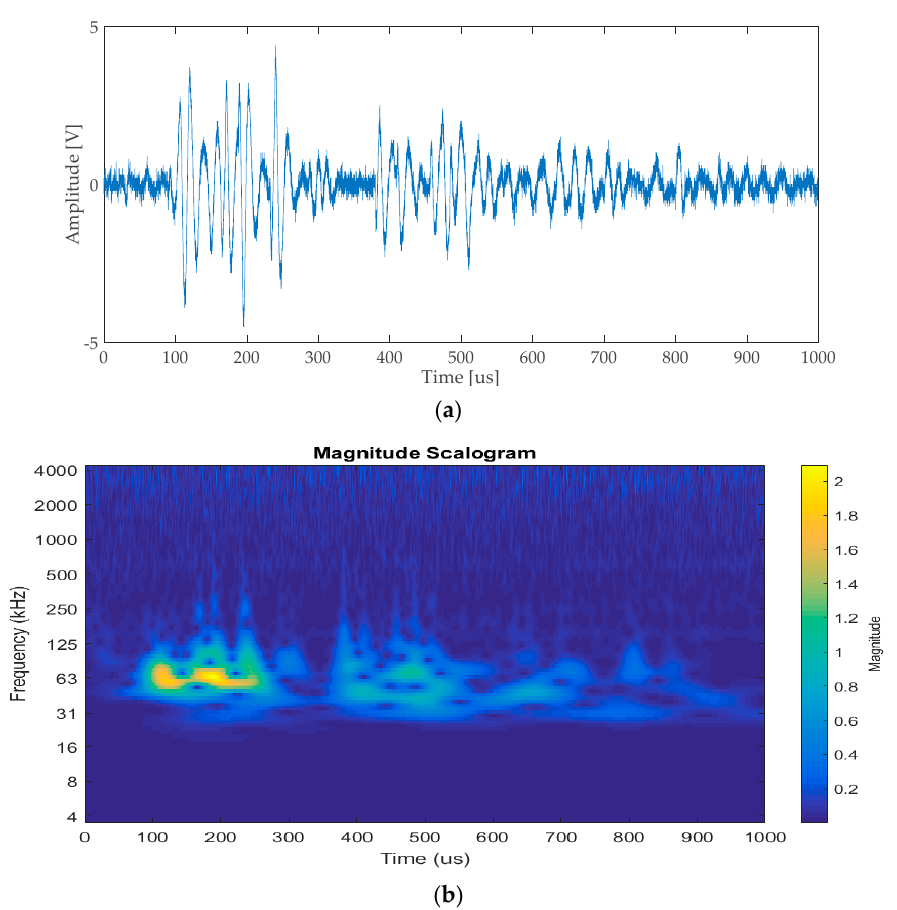
Figure 4. ( a ) Signal generated by a metal sphere impacting on the plate, acquired with an acoustic emission (AE) transducer (Brüel & Kjær Type 8313); ( b ) spectrogram obtained through continuous wavelet transform (CWT).